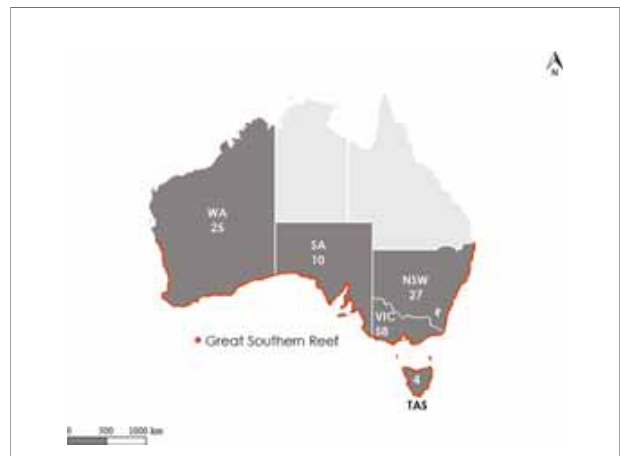
FIGURE 1 | Number of returned surveys per each of the 5 states (WA, Western Australia; SA, South Australia; VIC, Victoria; TAS, Tasmania; NSW, New South Wales) bordering the Great Southern Reef (highlighted by the red